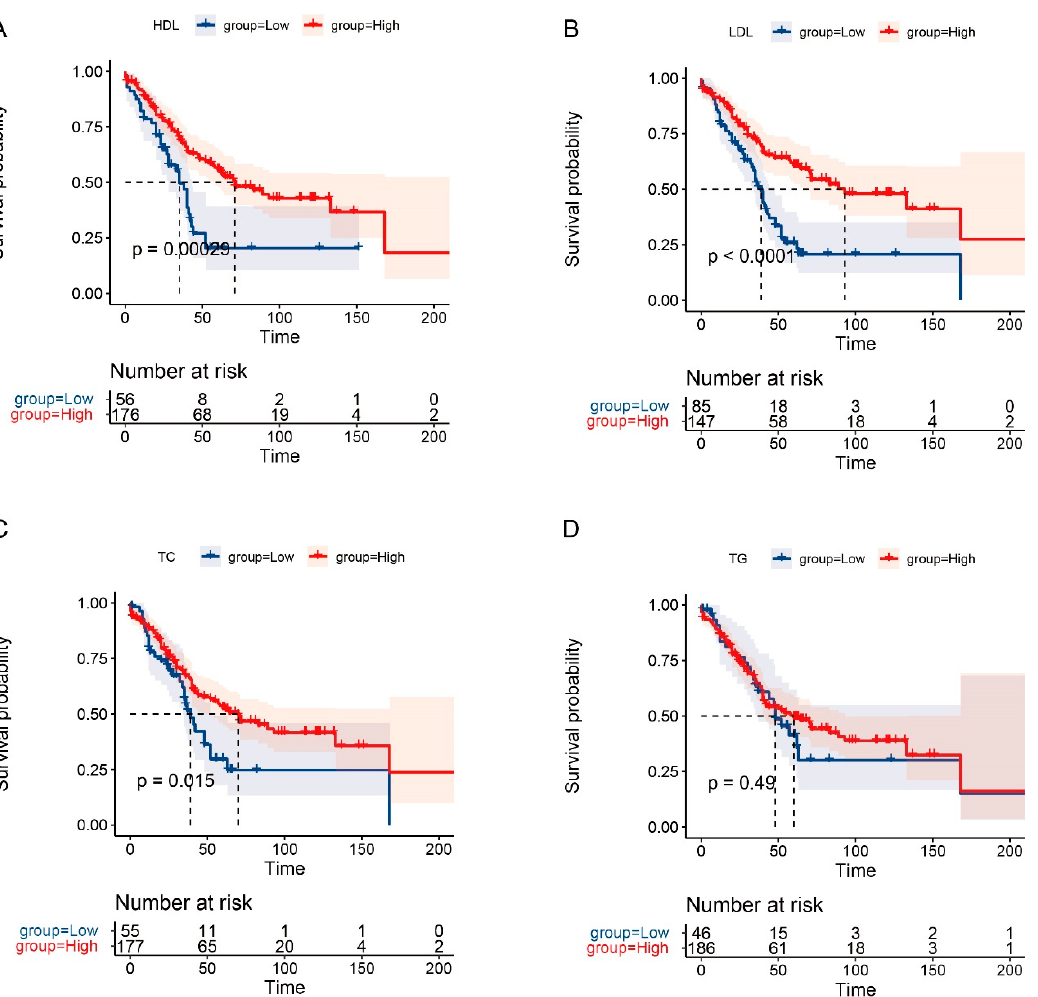
Figure 2. Survival analysis of OS for AC patients. KM curves of OS for HDL ( A ), LDL ( B ), TC ( C ), and TG ( D ).